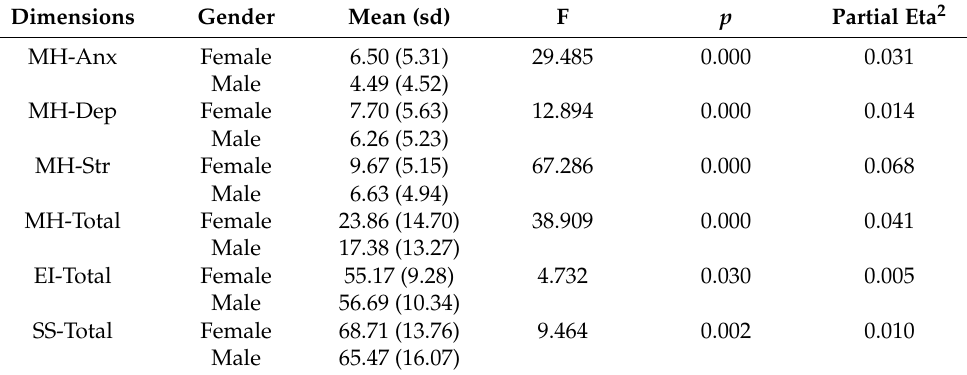
Table 3. Gender differences of mental health, emotional intelligence and social